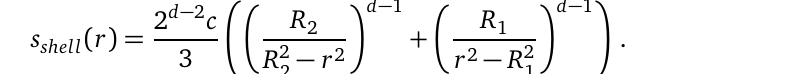
Figure 10: This figure shows the entanglement contour function s = 4, R = 6 in d = 3,4,6,10 dimensional shells with c = 1, R 1 2